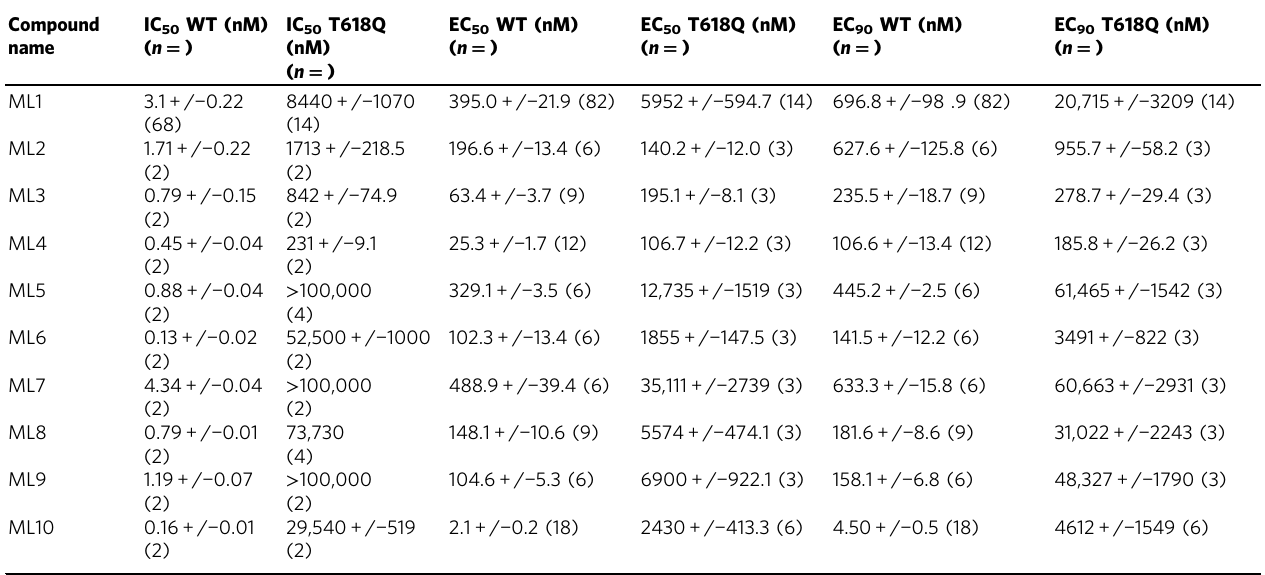
Table 1 Compound potency in kinase and cell-based assays Compound